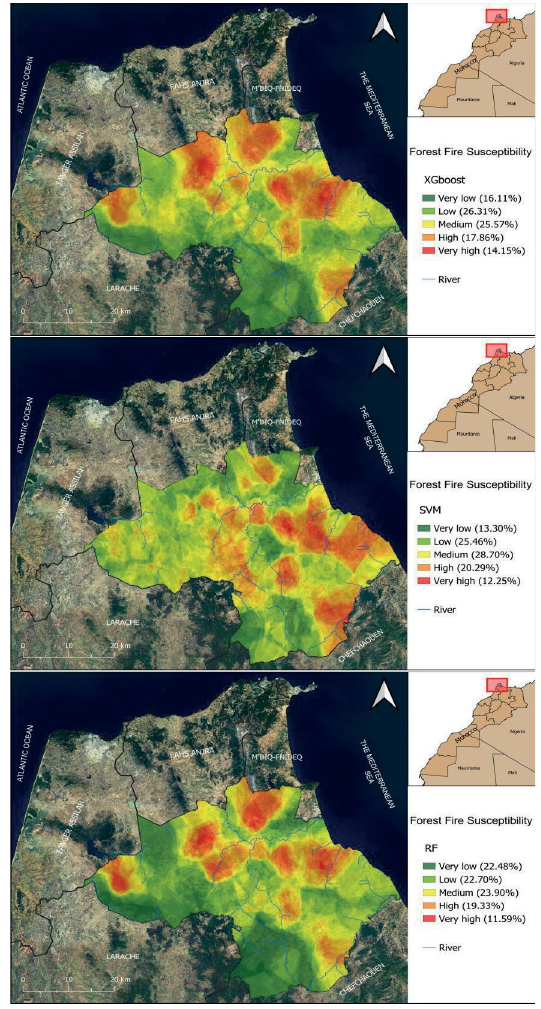
Figure. 7. Forest Fire Susceptibility using the 3 ensemble